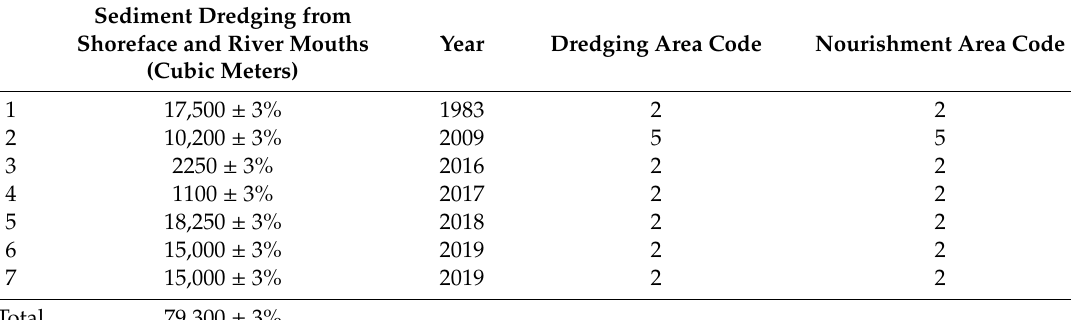
Table 6. Volume of sediments dredged from nearby shoreface and redistributed as sediment transfer in the 1980–2020 timespan along the considered sector of coast, sorted by year of occurrence. Refer to Table S2 for a detailed list of each transfer